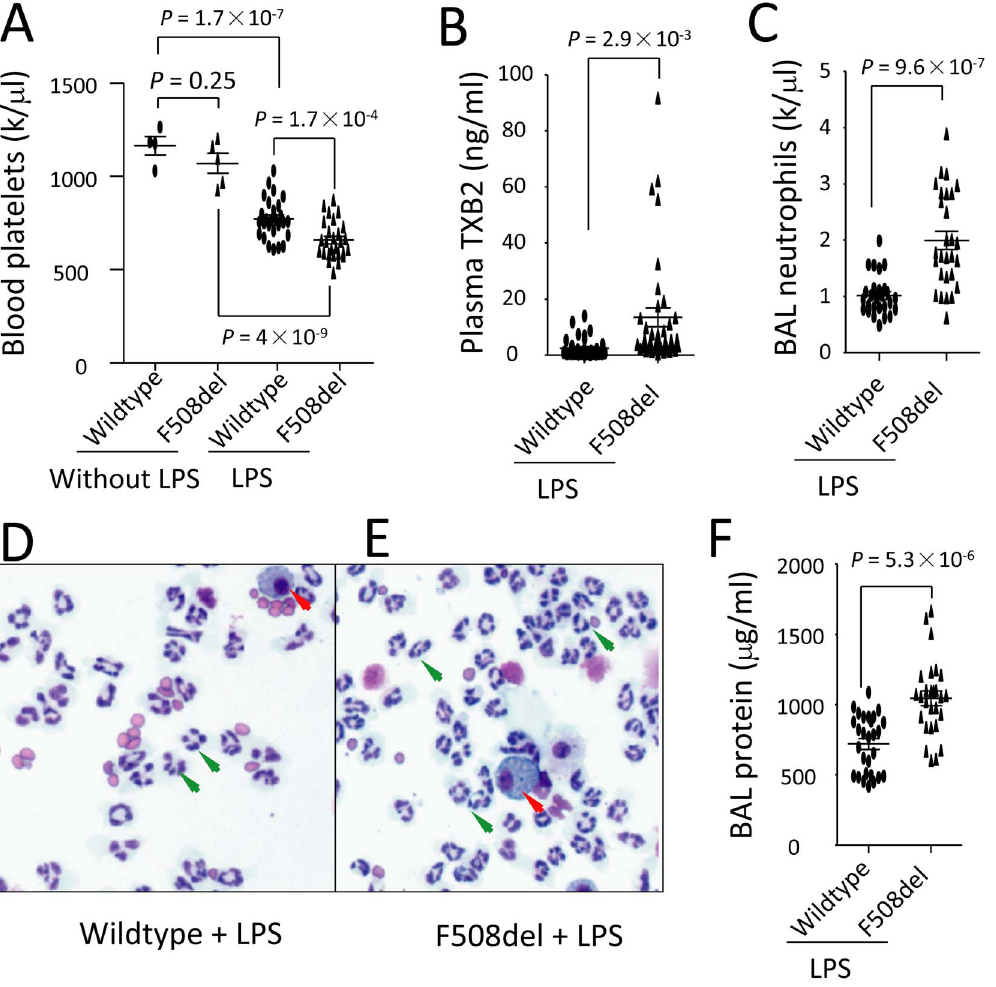
Figure 1. Reduction of blood platelets coincides with worsened lung inflammation in F508del mice that were intratracheally challenged with LPS. Wild-type and CFTR mutated mice were intratracheally challenged with either PBS (for Figure 1A) or LPS. The mice were killed at 24 h after challenge. A. Blood platelet counts were accessed (n=4–5 in before LPS group; n=27, in LPS-challenged group); B. Plasma TXB2 levels were measured by ELISA (n=37, in each group); C–E. BAL neutrophils (n=28, in each group) counted by Hemavet analyzer and cytological examination (Wright’s stain; magnification 6 100; red arrow head indicates alveolar macrophage; green arrow head indicates neutrophils); F. BAL protein levels (an indicator of lung endothelial and epithelial permeability, n=28, in each group). Data were pooled from more than 5 independent experiments with LPS challenge. Data were analyzed by ANOVA and t-test and presented in mean 6 SD. P values are listed on each panel.